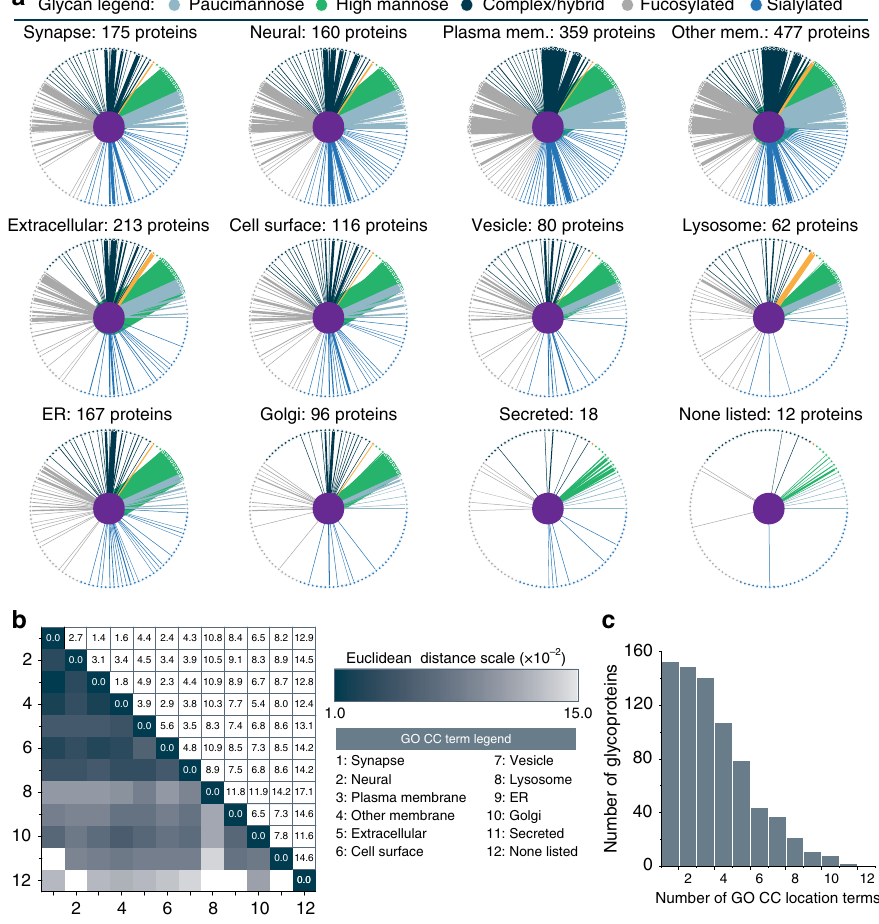
Fig. 6 Delineating glycosylation pro fi les by subcellular cellular locations. a Glycosylation pro fi les for glycoproteins from 12 subcellular locations (derived from GO cellular component terms) are shown, with colors indicating glycan type and line thickness indicating frequency. Orange denotes mannose-6- phosphate. b Euclidean distances were calculated between each of the 12 subcellular localizations to indicate similarity in their glycosylation types (darker indicates a higher degree of similarity). c Number of GO cellular component terms associated with identi fi ed